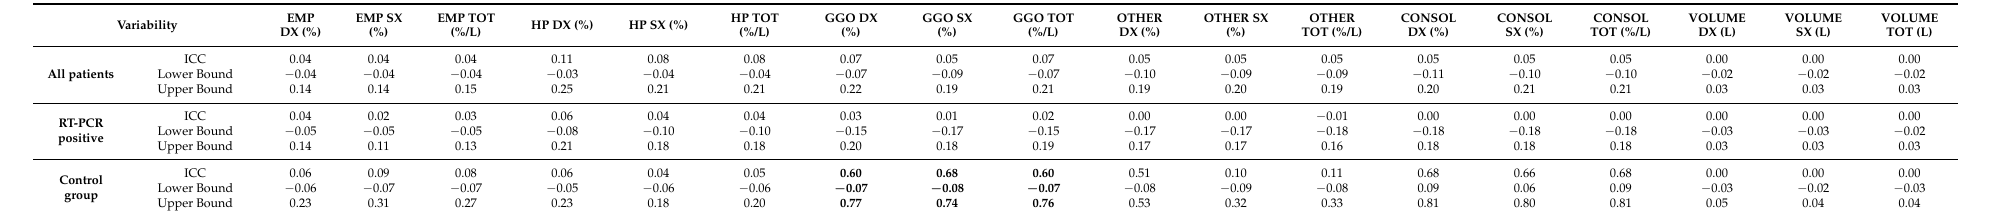
Table 2. The intraclass coefficient (ICC) among quantitative volumes obtained using different commercial computerized tools on baseline CT scans. Variability